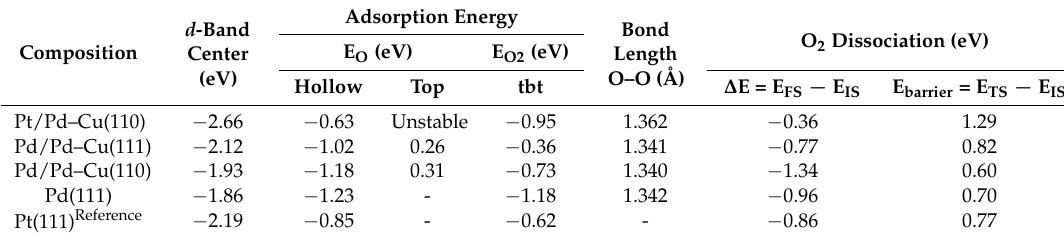
Table 2. The calculated d -band center ( ε d ), adsorption energies of atomic O (E O ) and O 2 (E O2 ) and key parameters for O 2 dissociation process including bond length, activation energy ( ∆ E) and energy barrier (E barrier ). Note that the energy of atomic oxygen is defined as the half of that of O 2 . For O 2 dissociation process, the initial state (IS) corresponds to the most stable O 2 adsorption, the final states (FS) corresponds to two separate atomic oxygen atoms adsorption and the transition state (TS) is obtained by NEB calculations. We have added the data of Pt(111) from Reference